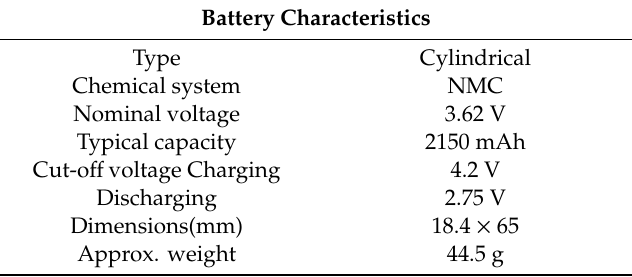
Table 1. Samsung 18,650 battery specification provided by manufacturer